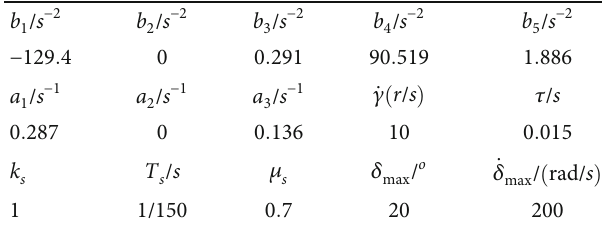
Table 1: Parameters for a gliding-guided